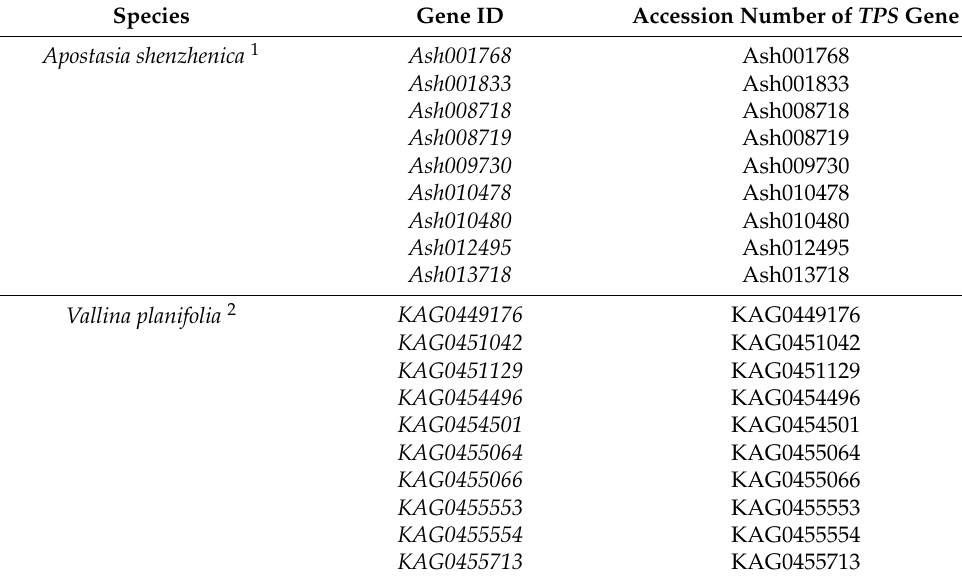
Table A1. TPS genes used in phylogenetic